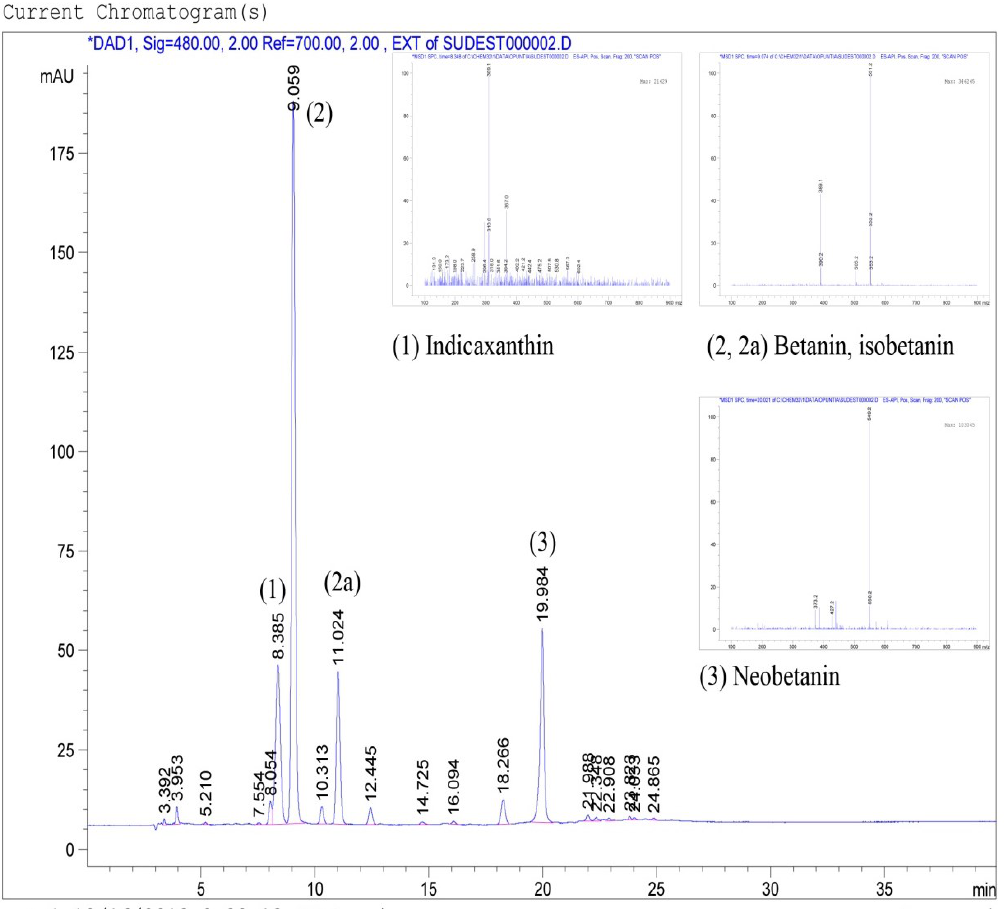
Figure 2. HPLC chromatogram of the cactus pear fruit extract (purple variety); MS fragmentation of the main peaks is also